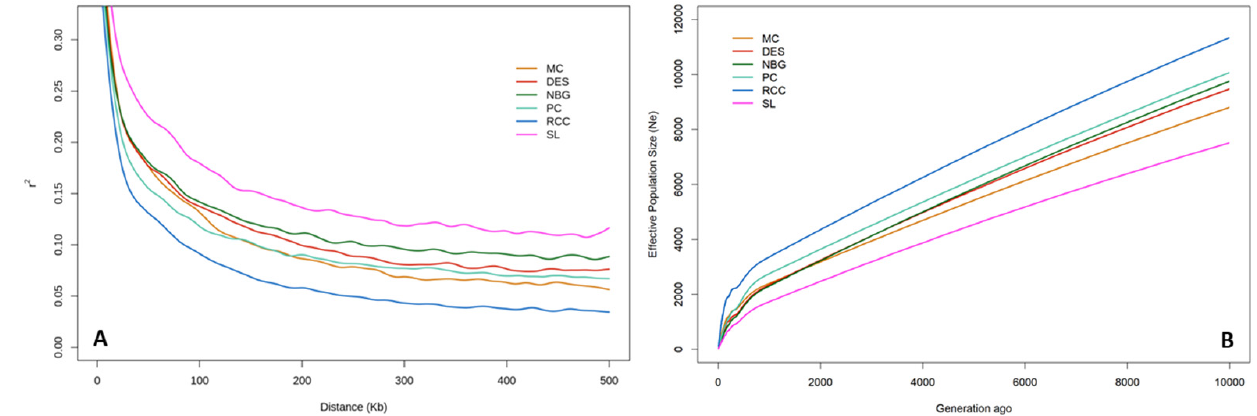
Figure 6. Linkage disequilibrium (LD) decay and effective population size (Ne) of six Bangladeshi cattle populations. LD decay was measured as the average squared correlation coefficient of allele frequencies at pair of loci (r 2 ) over genomic distance ranging from 0 to 500 Kb ( A ). Ne of each population was calculated through the SNP based LD analysis over the last 10,000 generations ago ( B ). Cattle breeds/population abbreviations are similar to Figure 1.